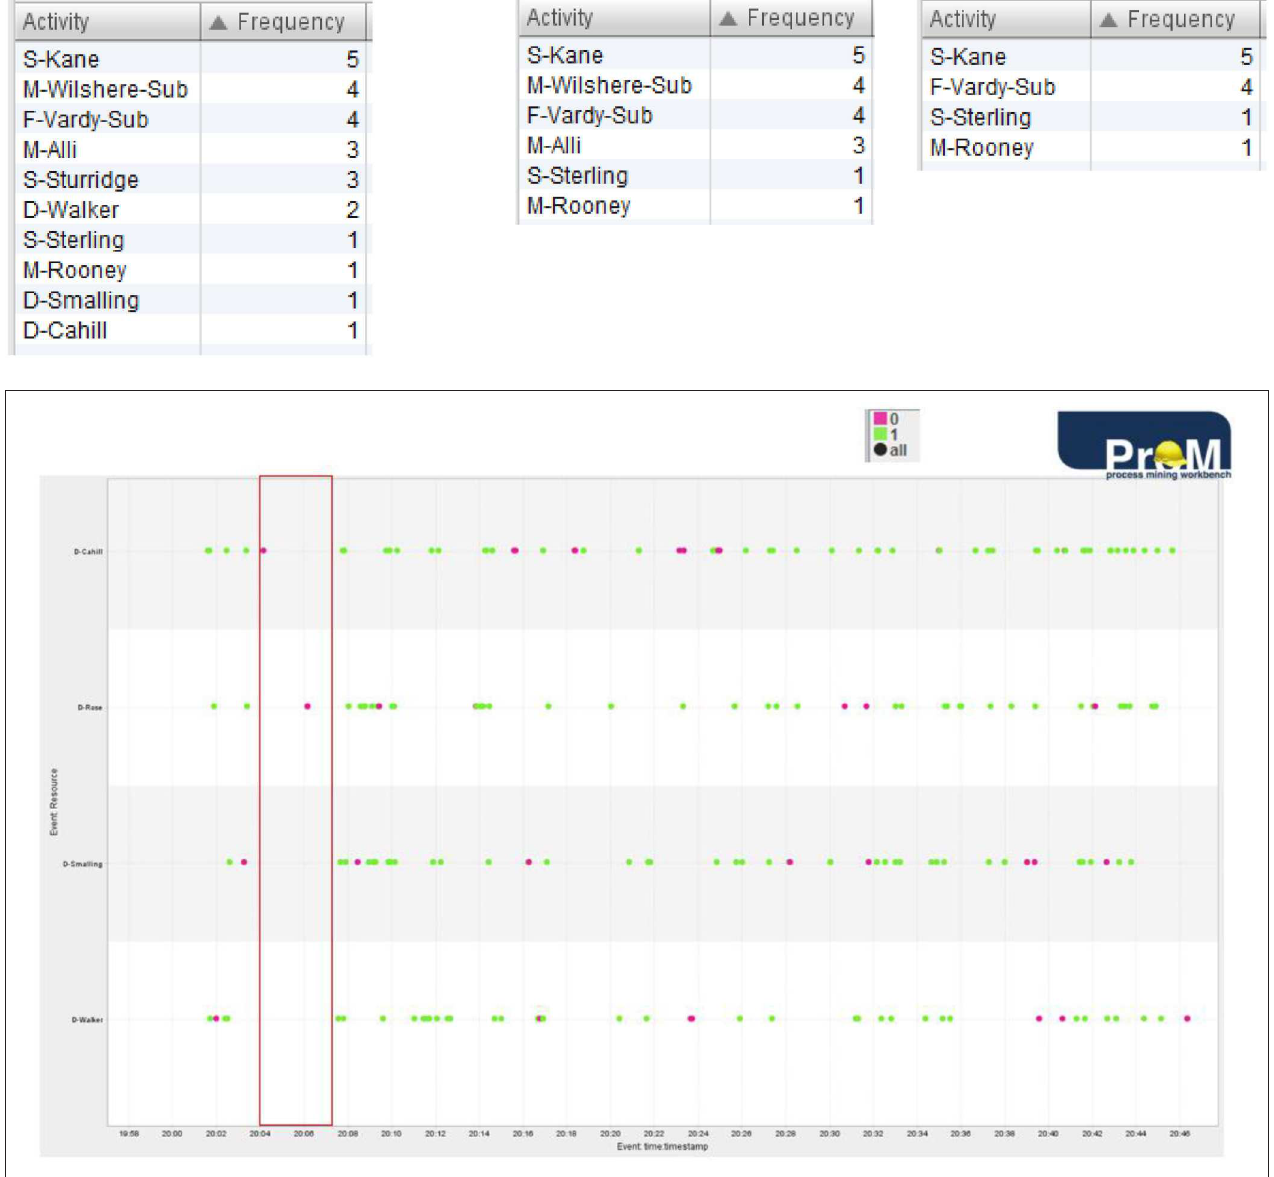
FIGURE 5 | Outcome of activities of England’s defenders in